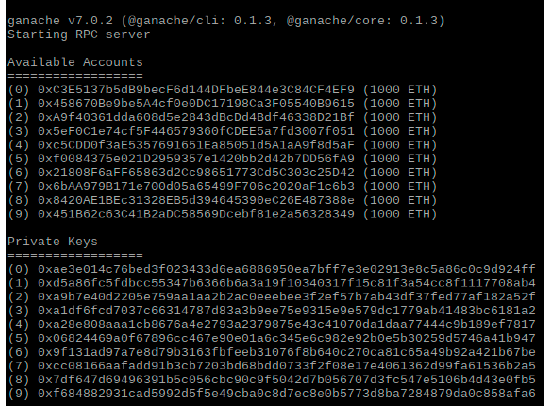
Figure 5. Ganache blockchain server.